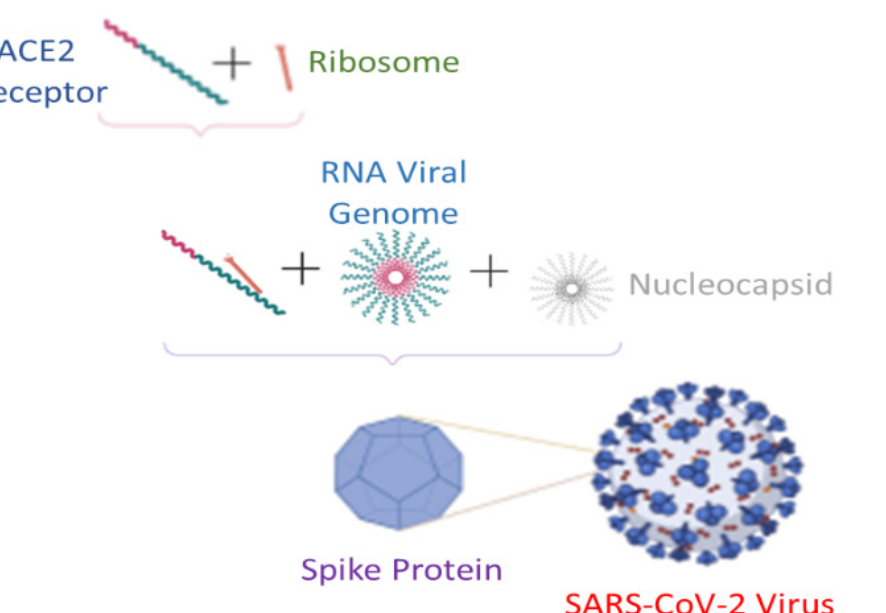
Figure 4. Self-assembly in spike protein Figure 4. Self ‐ assembly in spike protein formation.